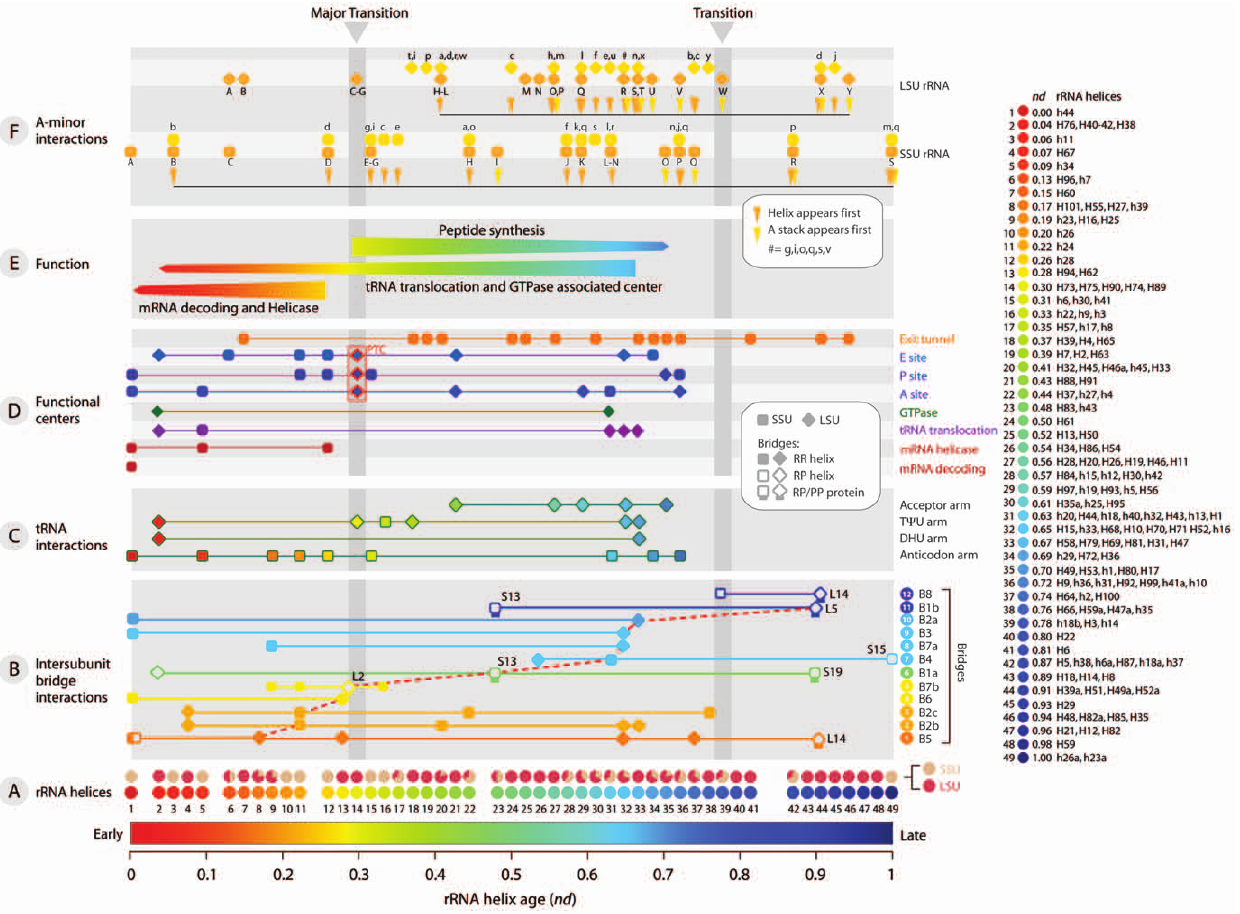
Figure 3. Timeline of development of the functional centers of the ribosome. A , The relative age ( nd ) of different rRNA helices (colored circles) increases from left to right and SSU and LSU functional elements are indicated with squares and rhomboids, respectively. Pie charts below each time point show the percentage of SSU and LSU helices appearing at that time, and the two periods of evolutionary transition are shaded. B , Timeline of structures in bridges. The age of bridge interactions is assigned as the age of first acceptor element of the donor-acceptor pair forming the bridge (red lines). C , Timeline of helices that interact with the different arms of tRNA. D , Timelines of helices that form the functional centers of the ribosome. The PTC is highlighted with a red box. E , History of functions. The width of the arrows portrays the increase of elements forming the center and time taken for its development. F , Timeline of A-minor interactions in SSU and LSU rRNA. Names with capital letters indicate the donor and in small case indicate the acceptor of the A-minor interaction.